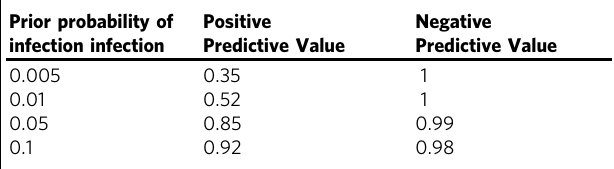
Table 3 Summary of the positive and negative predictive values for the detection dogs test for a range of prior probabilities of infection of COVID-19.